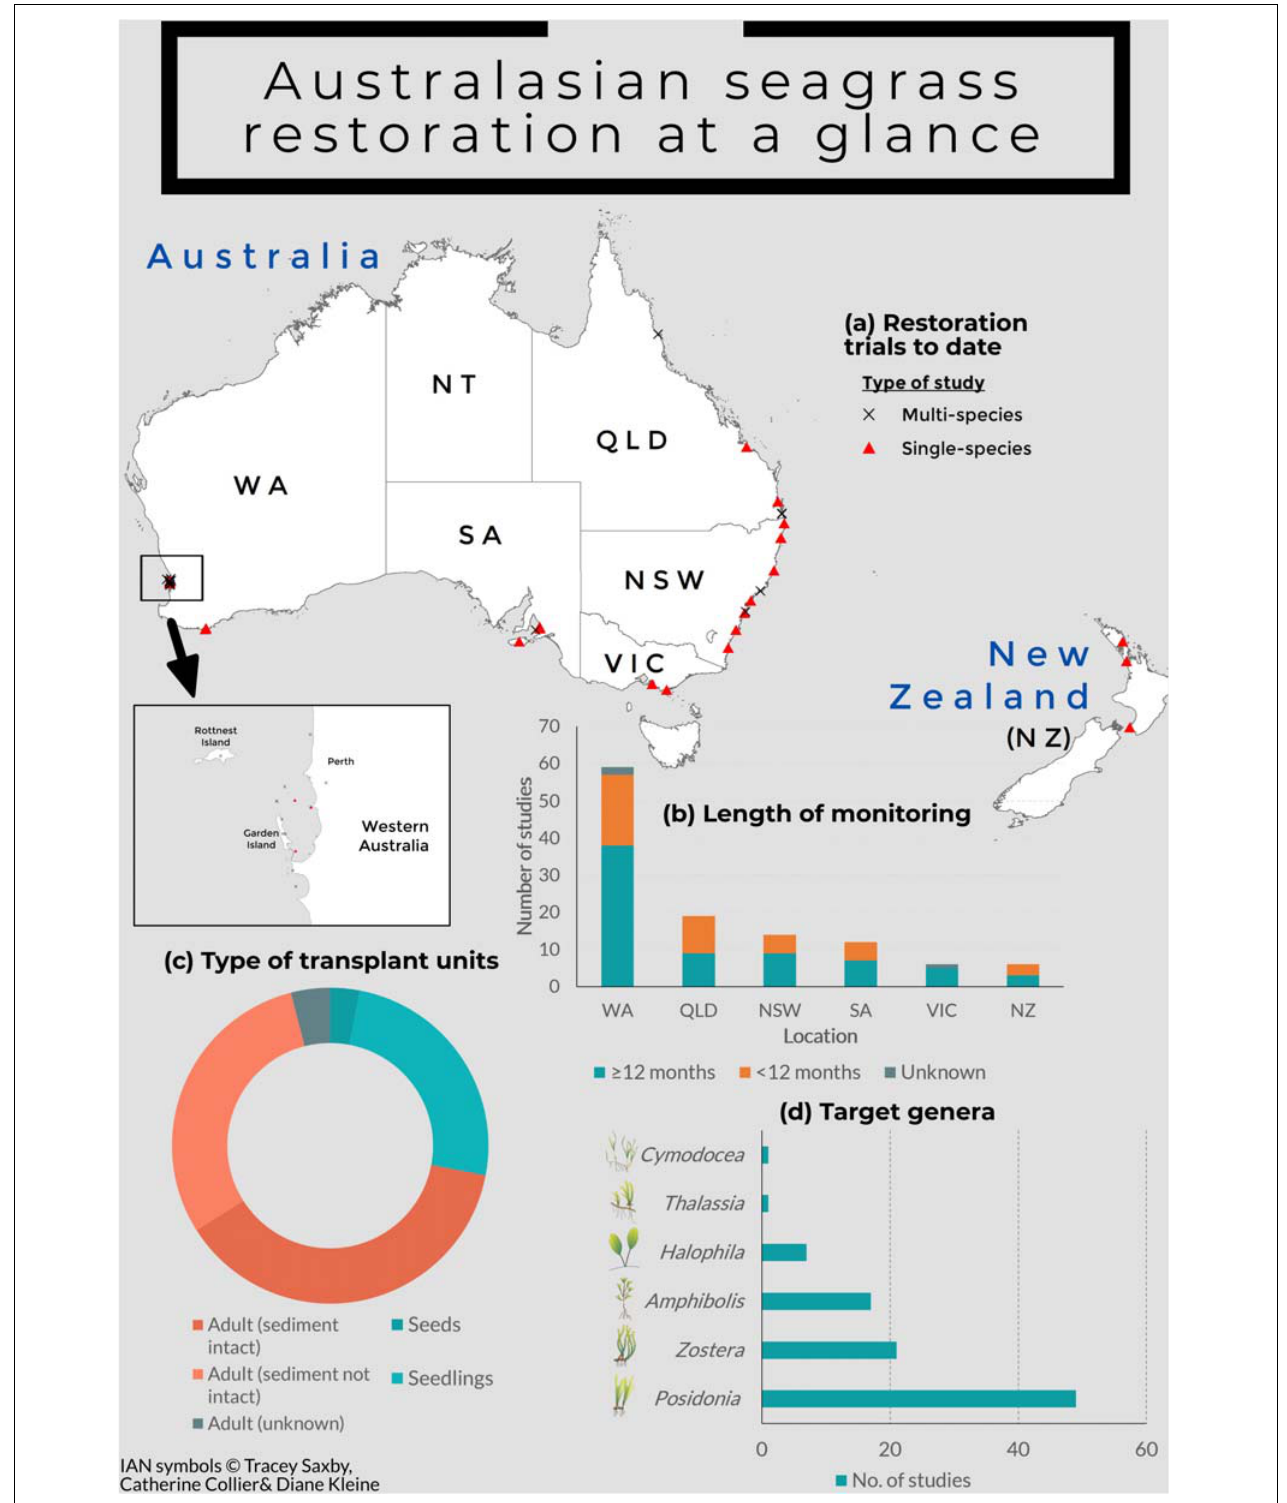
FIGURE 1 | Infographic showing (a) all seagrass restoration trials carried out to date in Australasia, with inset map showing the concentration of studies carried out in Cockburn Sound, Western Australia; (b) length of monitoring of seagrass restoration trials based on states, (c) the proportion of different types of transplant units used in restoration trials across Australasia; and (d) the target genera in restoration trials across Australasia.